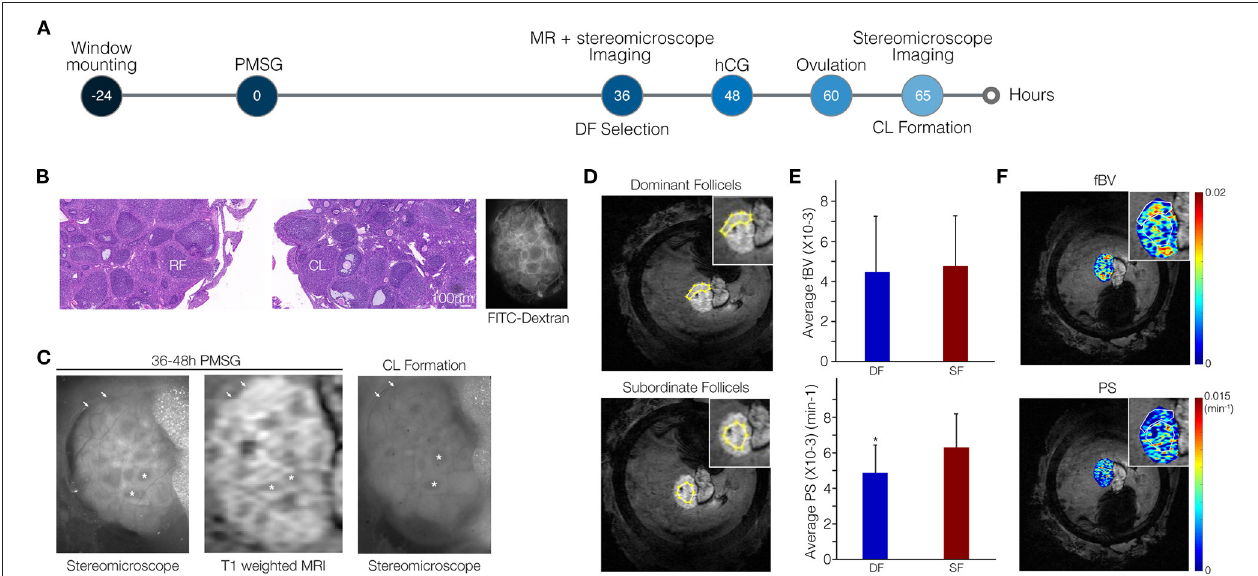
FIGURE 3 | Vascular permeability is suppressed in dominant follicles (DFs) relative to subordinate follicles (SFs). (A) Ovarian follicles were imaged through the MRI-compatible ovarian imaging window at 36–48h after PMSG injection by both DCE-MRI and fluorescent stereomicroscopy. Imaging was followed by hCG administration. On the following day, high-molecular-weight FITC-dextran was injected to the tail vein to visualize blood vessels and ovaries were imaged again under the stereomicroscope. (B) H&E stain showing the presence of ruptured follicles (RFs) and corpora lutea (CL) and FITC-dextran stereomicroscopy visualizes intact and functional blood vessels. (C) Fluorescent images and DCE-MRI (shown here at 6.5min post-contrast). Follicles that lost their antrum (DF) to became CL are indicated by arrows. Follicles that did not ovulate and maintained their antrum (SF) are indicated by asterisks. (D,E) Representative example for regions of interest in the MRI images selected according to the fluorescent images (D) to analyze PS and fBV of DF and SF separately ( E ; n = 5, p = 0.02). (F) Corresponding pixel-by-pixel